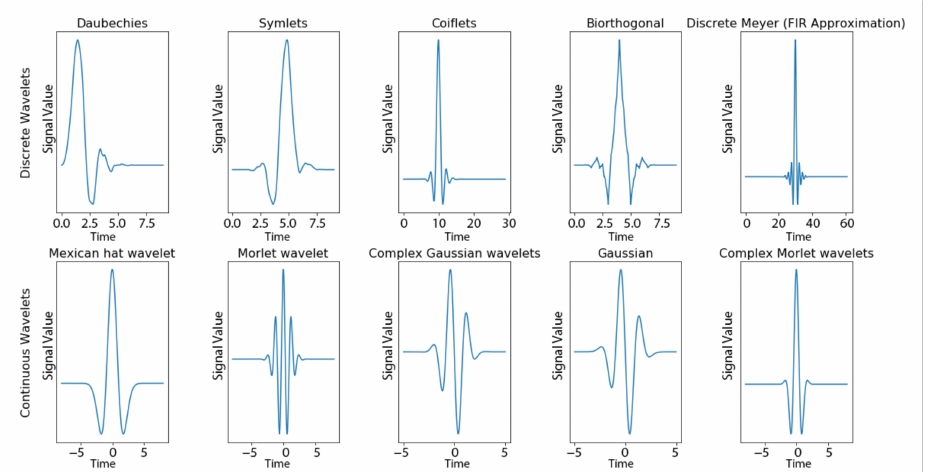
Figure 2. Examples of wavelet functions that are discrete ( top row ) or continuous ( bottom row